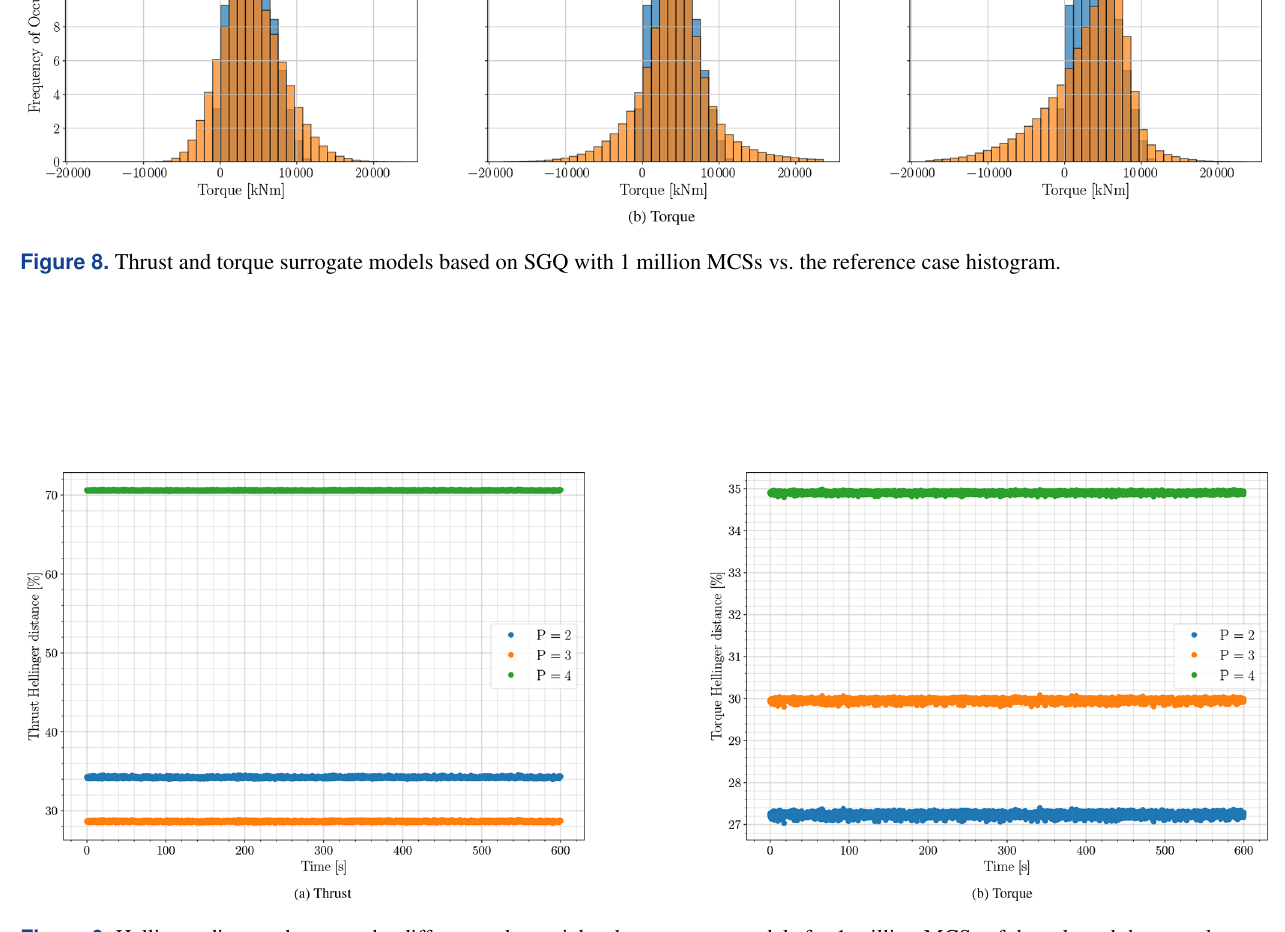
Figure 9. Hellinger distance between the different polynomial order surrogate models for 1 million MCSs of the selected thrust and torque SGQ surrogates and the 48000 reference case simulations at every time